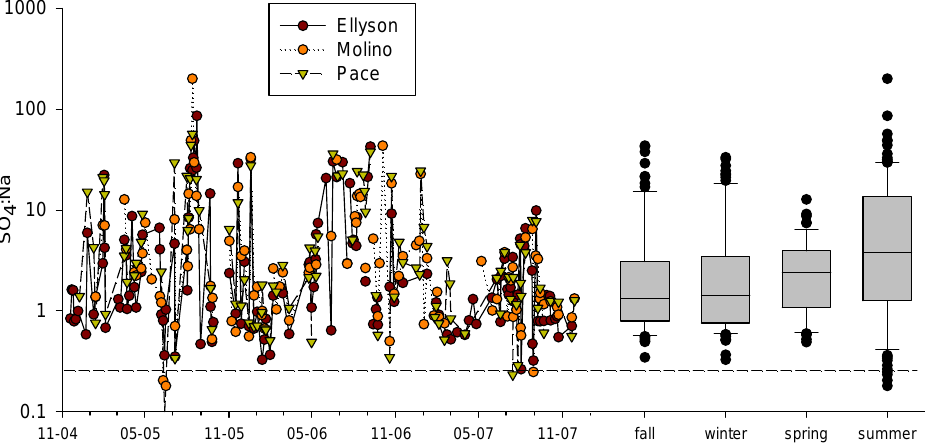
Fig. 6. Plot of the ratio of sulfate (SO 4 ) and sodium (Na) deposition at Pensacola Bay sites between November 2004 and December 2007 (left side). The seawater mass ratios (0.25 SO 4 :Na) is plotted as a dashed line. Box plot (right side) of SO 4 :Na by